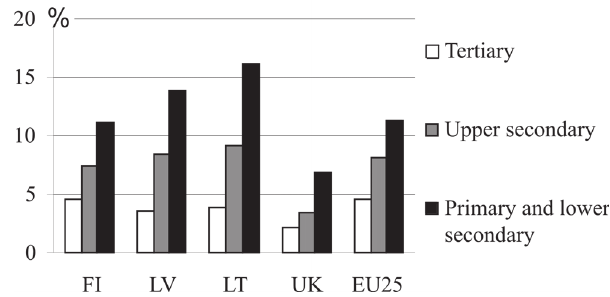
Fig 5. Unemployment rates of the total population by level